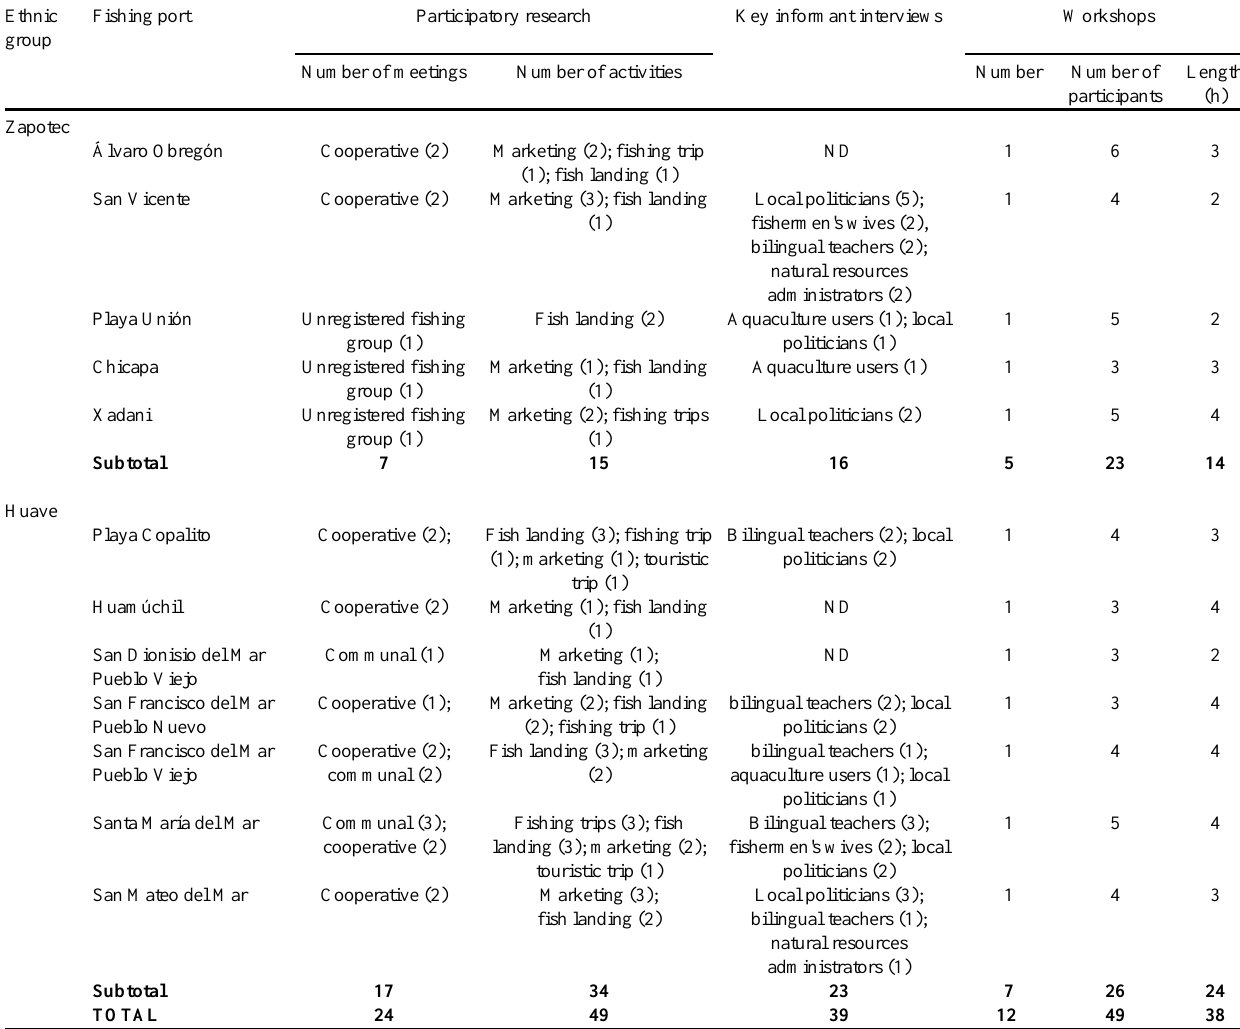
Table 2 . Research strategy (participatory research, key informant interviews, and workshops) to collect the Traditional Ecological Knowledge from Zapotec and Huave ethnics in the Huave Lagoon System,